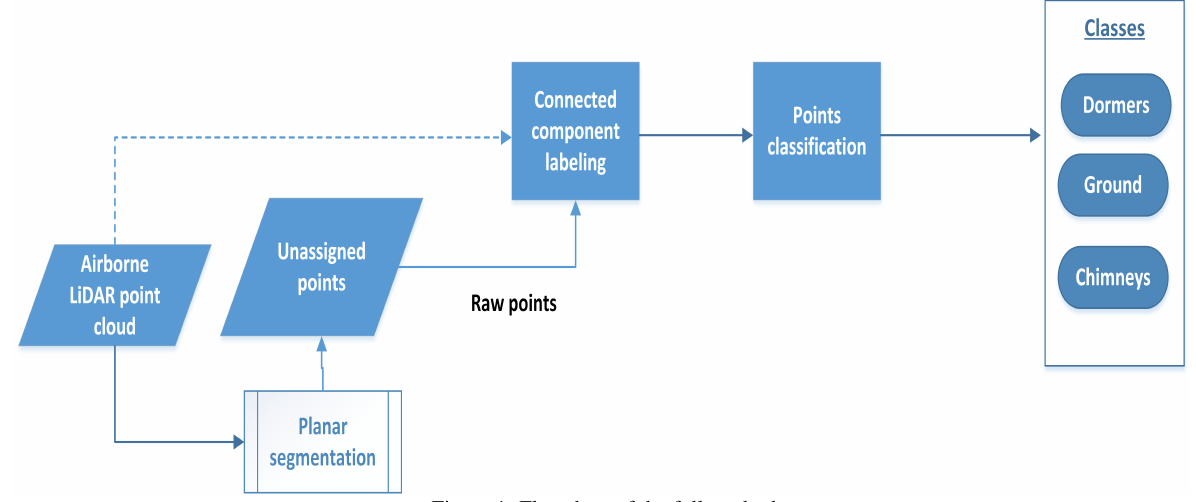
Figure 1. Flowchart of the full method Algorithm 1: Connected component